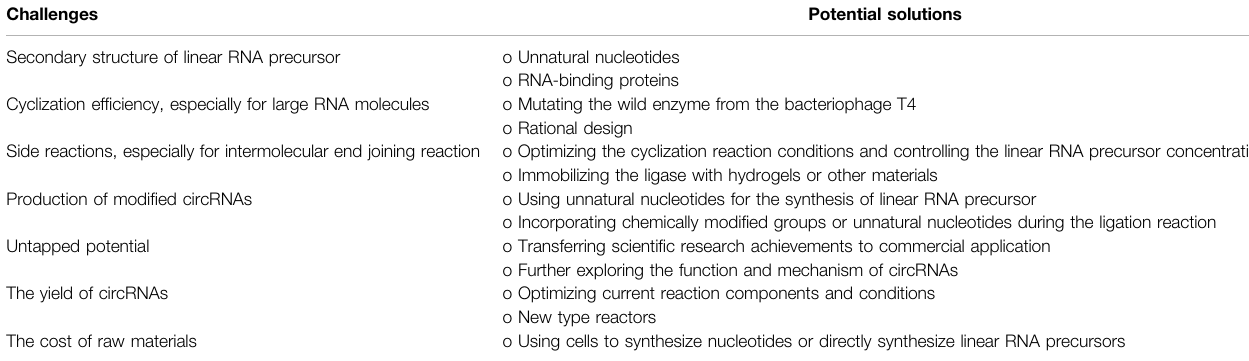
TABLE 2 | Challenges and potential solutions for